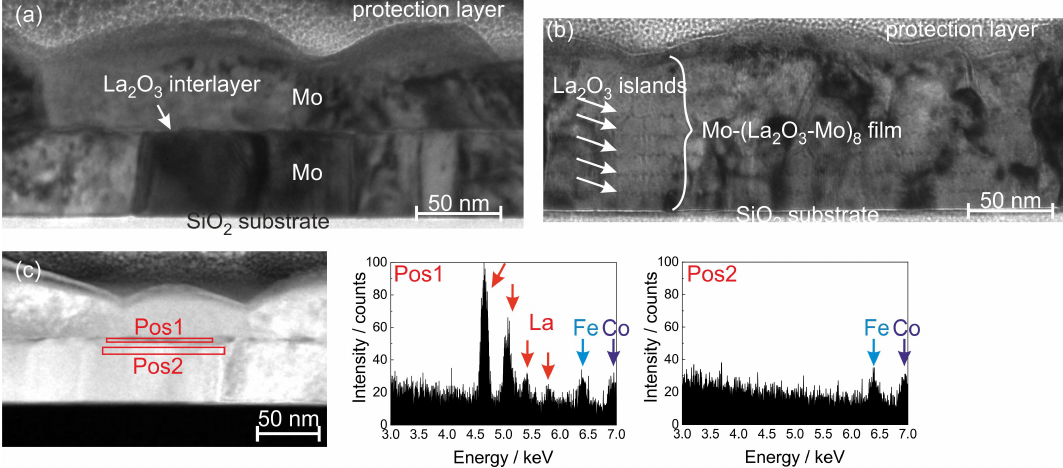
Figure 5. Transmission electron microscopy (TEM) study on Mo-(La 2 O 3 -Mo) n multilayer systems deposited on SiO 2 /Si after annealing at 800 ◦ C for 120 h in high vacuum: bright field TEM image of FIB cross-section lamellas of ( a ) a Mo-(La 2 O 3 -Mo) and ( b ) a Mo-(La 2 O 3 -Mo) 8 film, ( c ) Scanning